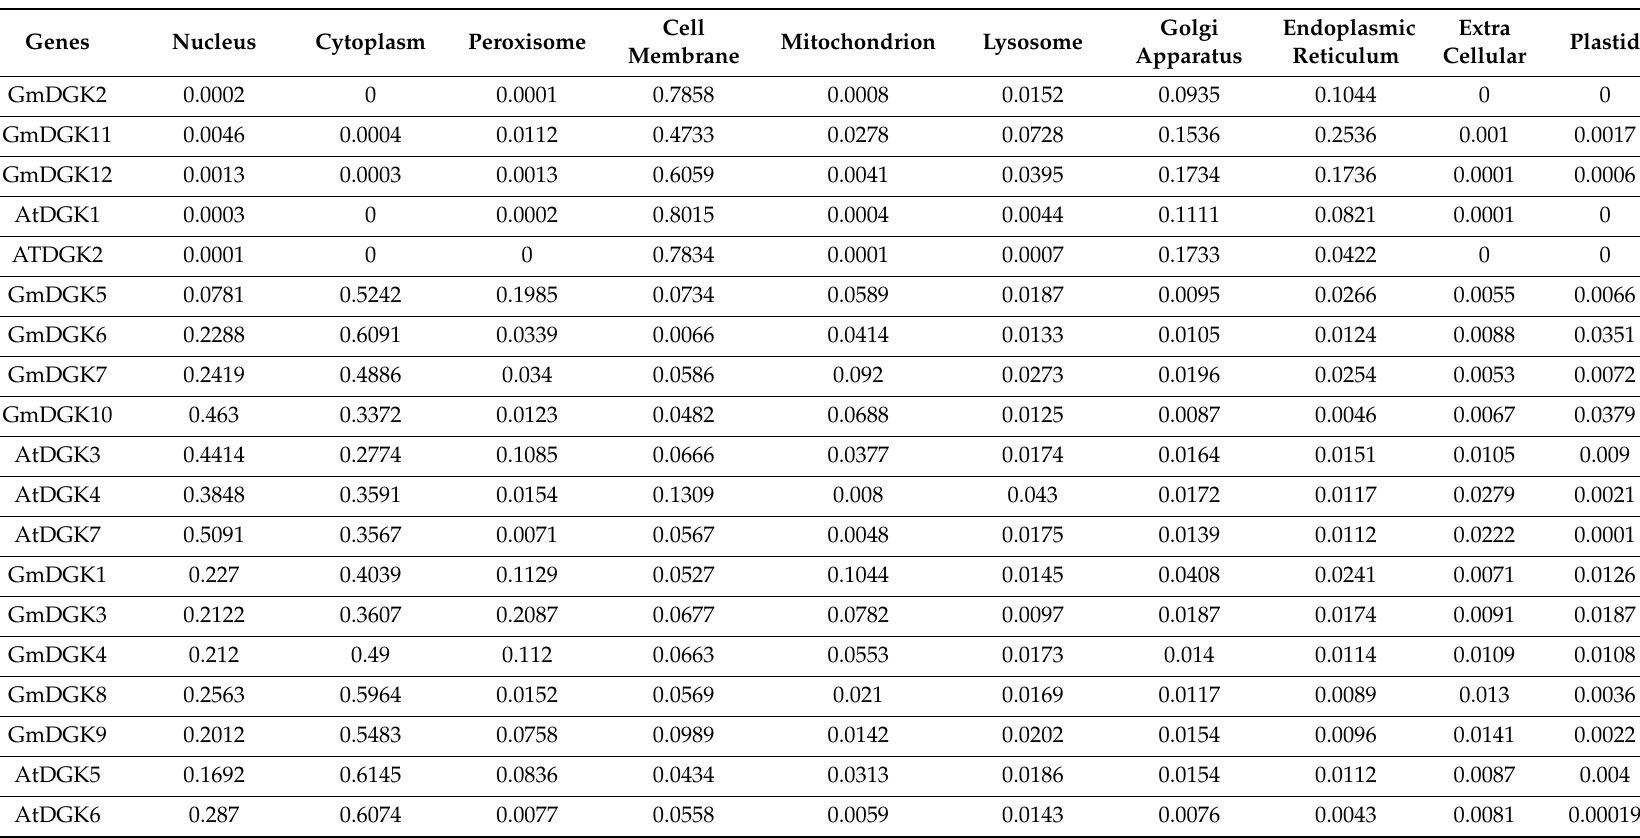
Table 1. Subcellular localization data found on DeepLoc-1.0; the uncolored cases represent the highest values for each gene in di ff erent parts of the cell. From top